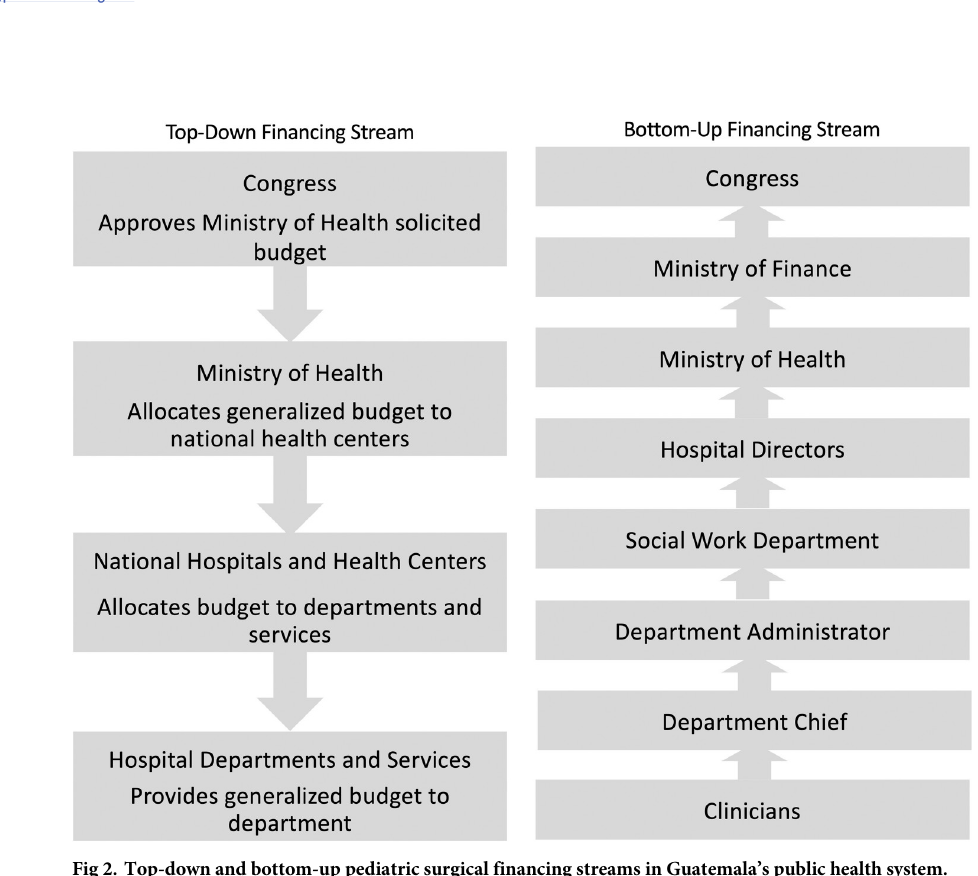
Fig 1. Financing streams for surgical care in Guatemala. Source: Adapted with permission from Becerill-Montekio and Lo´pez-Da´vila (2011) to match qualitative findings.